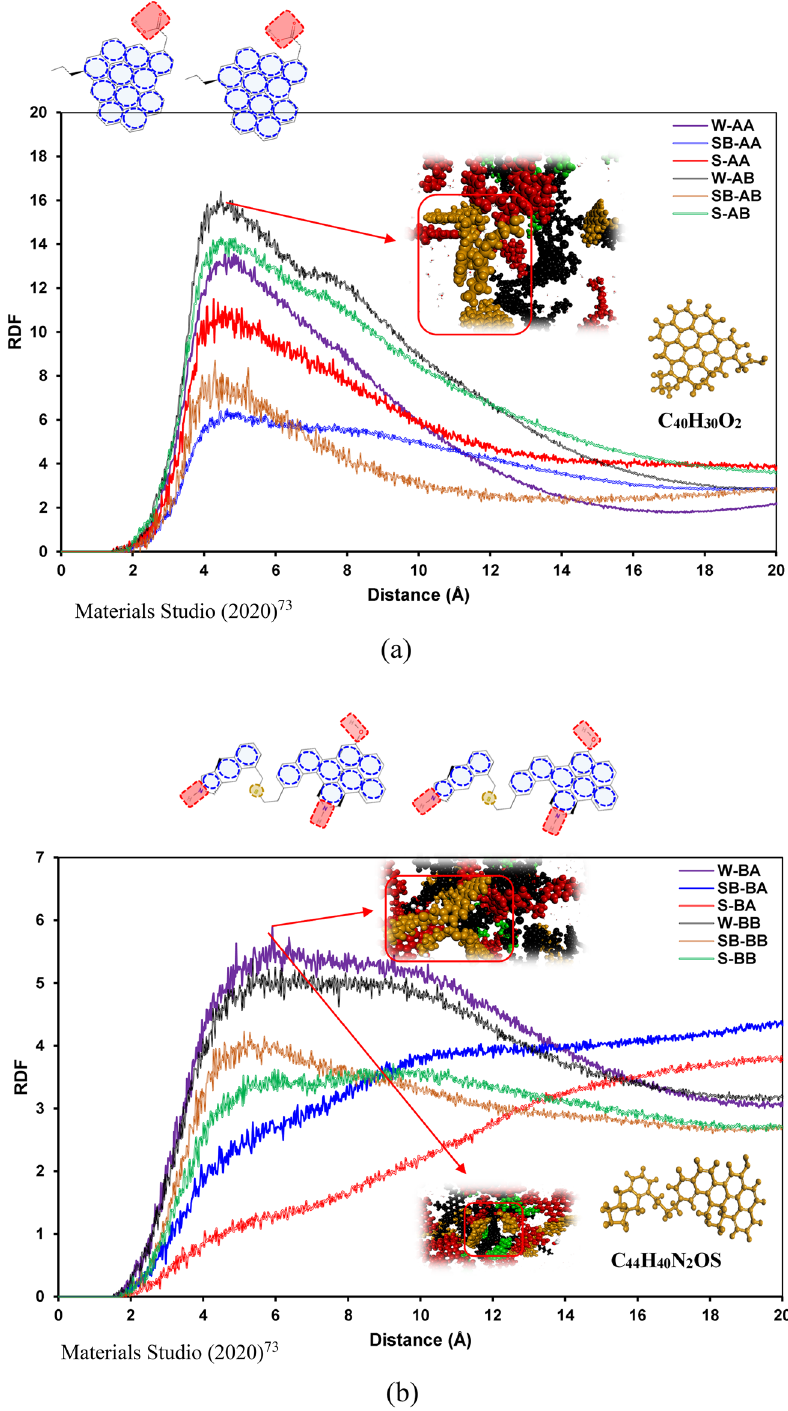
Figure 3. RDFs of the asphaltene molecule pairs containing ( a ) C 40 H 30 O 2 and ( b ) C 44 H 40 N 2